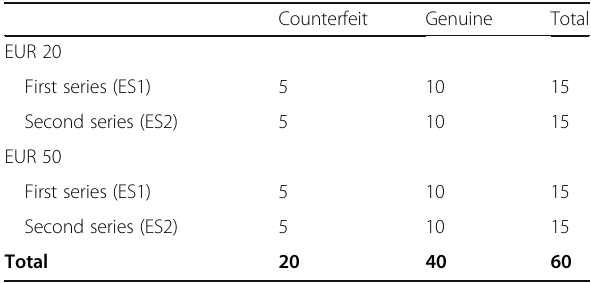
Table 1 Description of our stimulus set